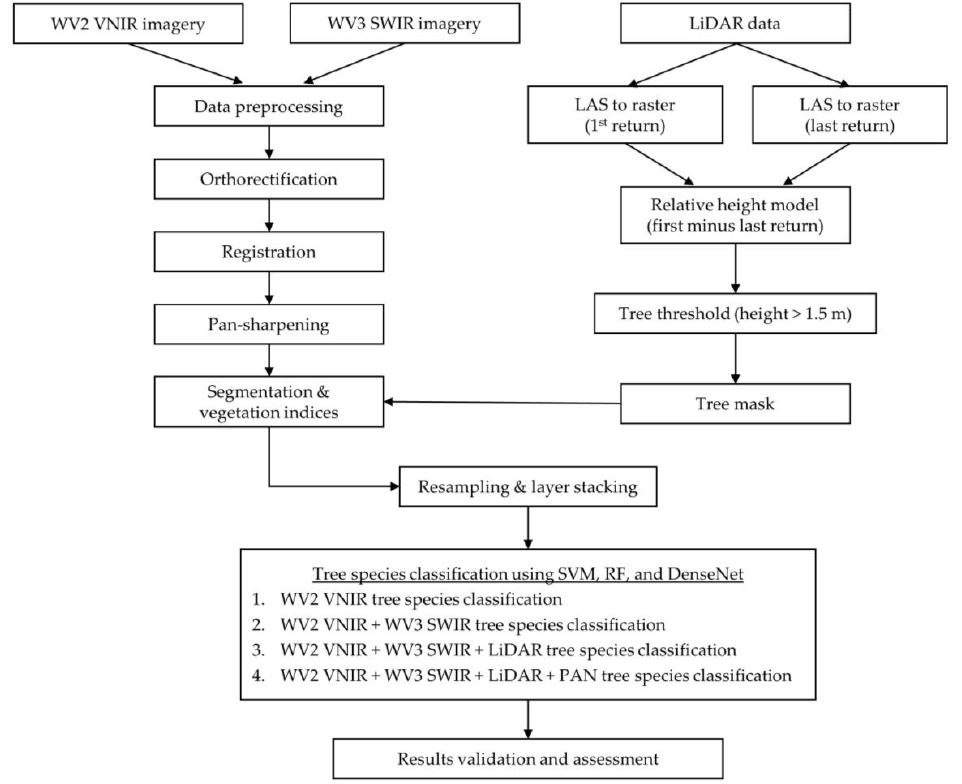
Figure 3. Classification workflow.